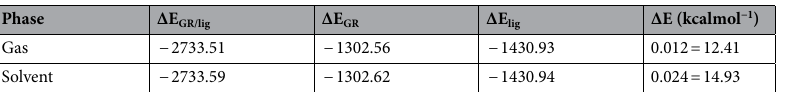
Table 2. Energy values (in au) of interacting adducts and calculated binding energy of carmustine ligand with GR calculated in gas phase and solvent phase. The active site of GR is calculated by UM062X/6-311 G (d,p)